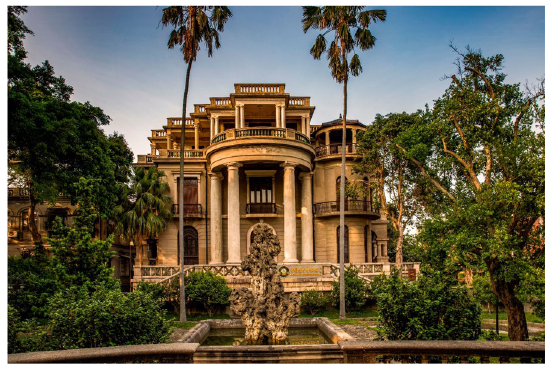
Fig. 2 Amoy Deco Style building in Kulangsu (Source: Cultural Heritage Conservation Centre of THAD, photo by Qian Yi. whc.unesco. org/en/documents/158225. Accessed 5 November